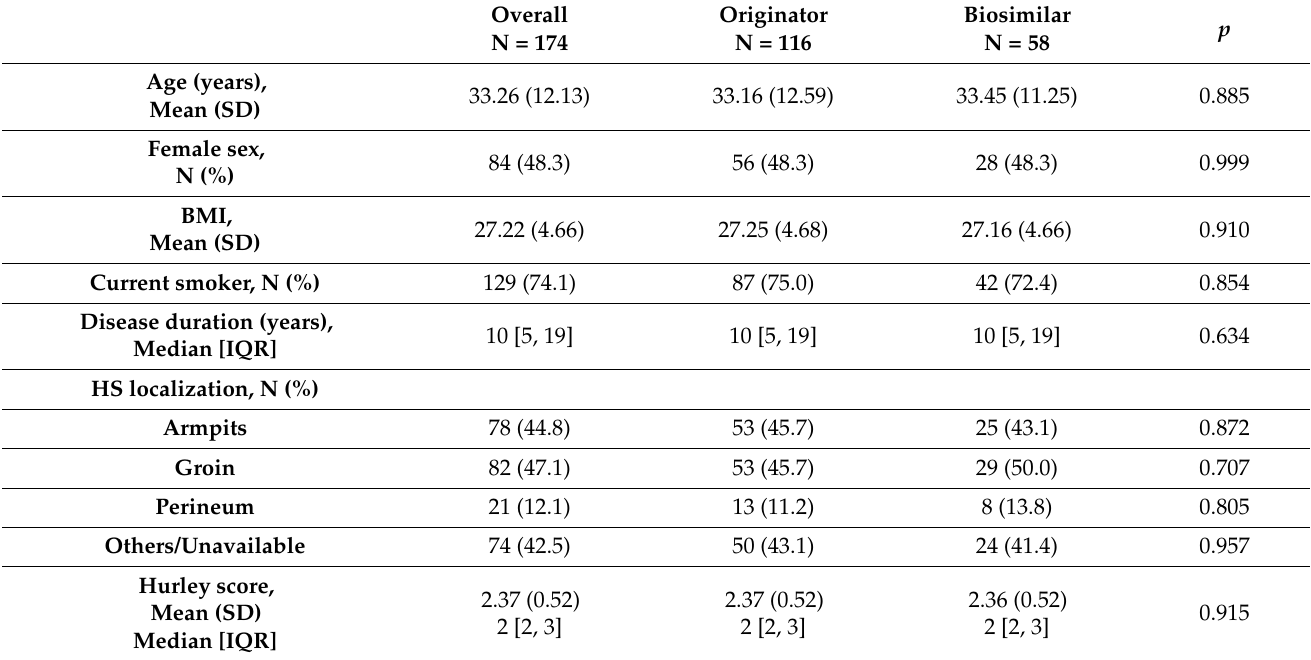
Table 1. Baseline demographic and clinical characteristics of patients included in the non-switcher analysis.